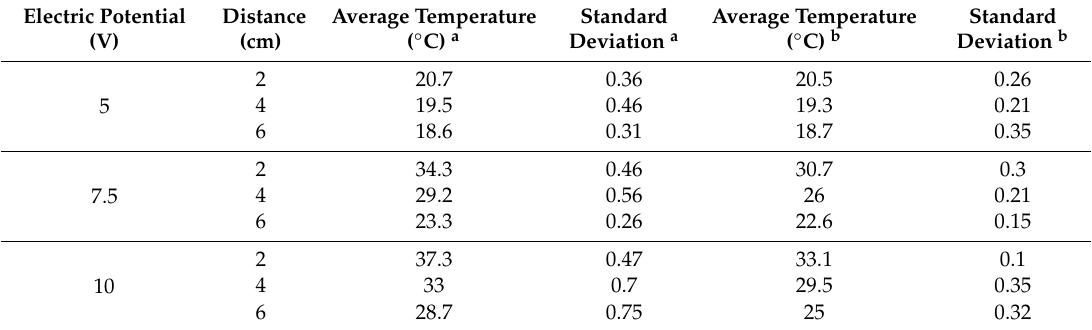
Table 3. Infrared thermography of EM4 with random and aligned fibers containing 0.5% TrGO recorded at di ff erent electric potentials and distances.